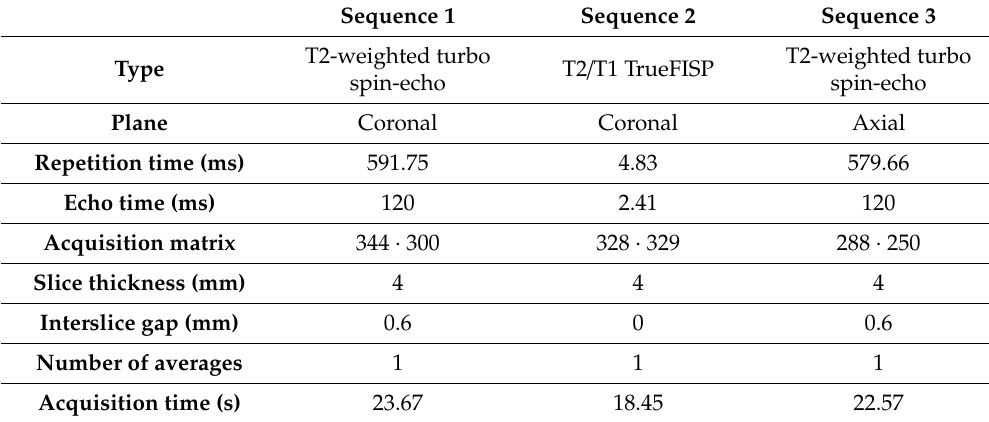
Table 1. MRI sequence